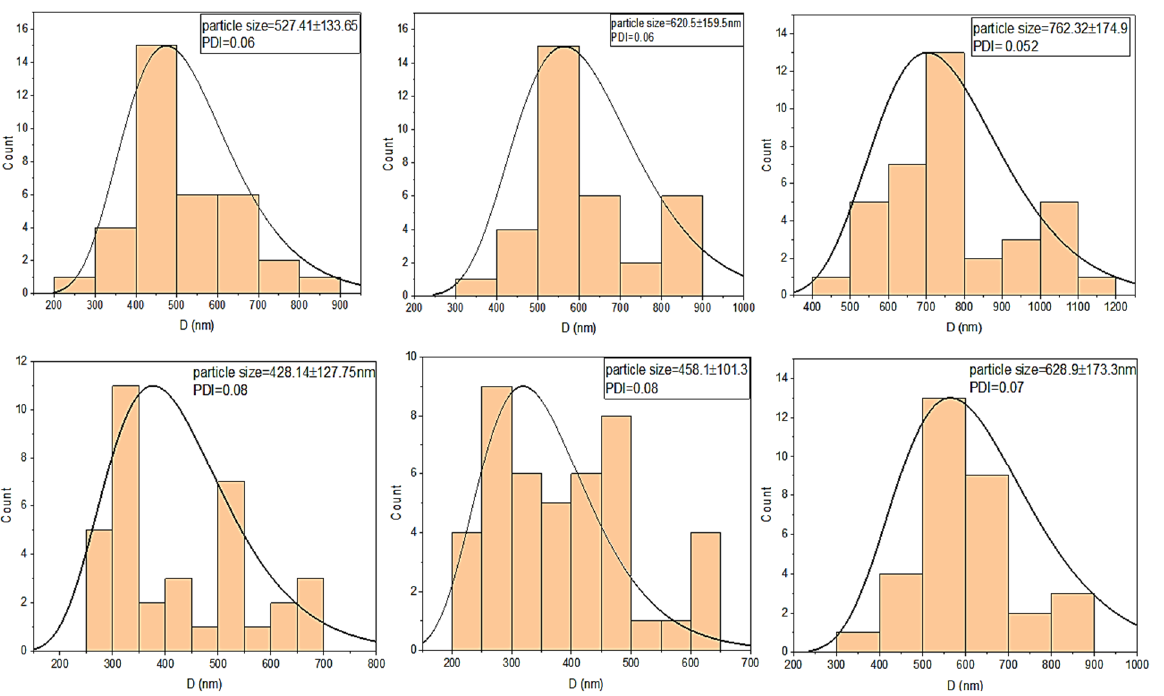
Figure 6. Particle-size histograms of pristine and amine-functionalized MgFe 2 O 4 nanoparticles calcined at different temperatures.